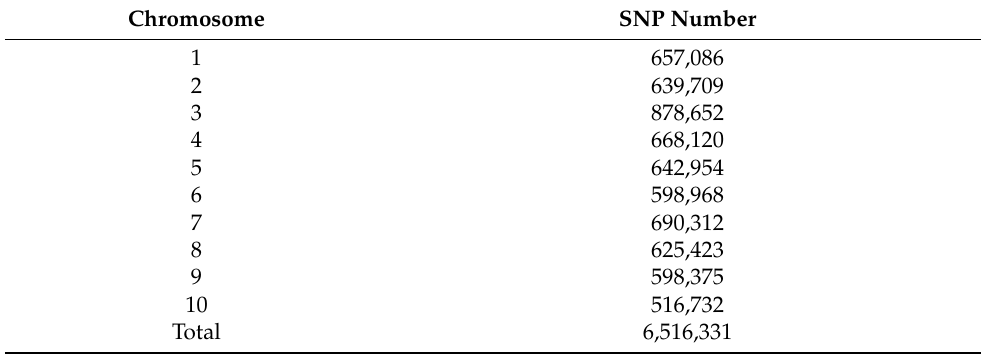
Table 2. Distribution statistics of high-quality SNPs on chromosomes.